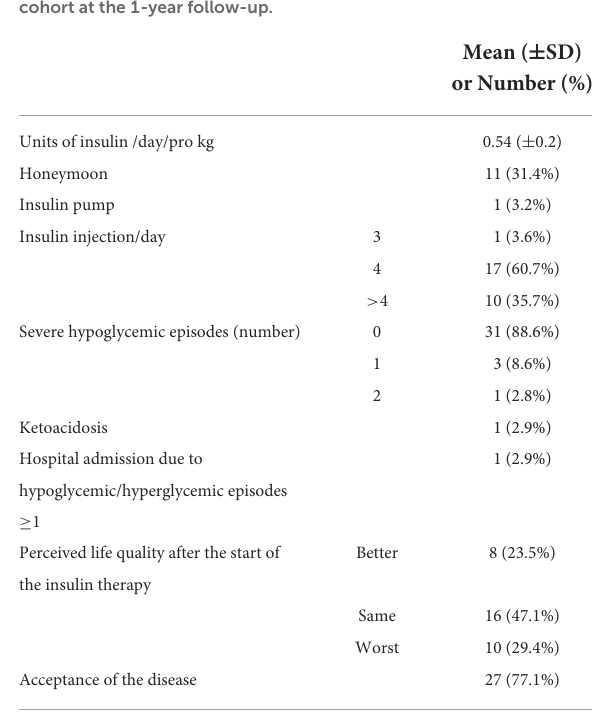
TABLE 1 Description of the clinically relevant data collected on the cohort at the 1-year